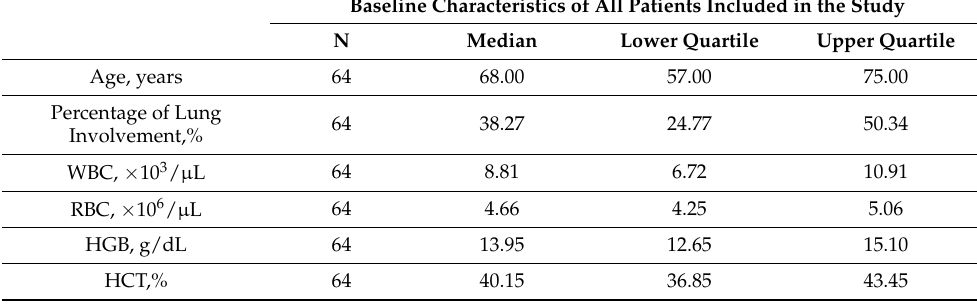
Table 1. Baseline characteristics of all patients included in the